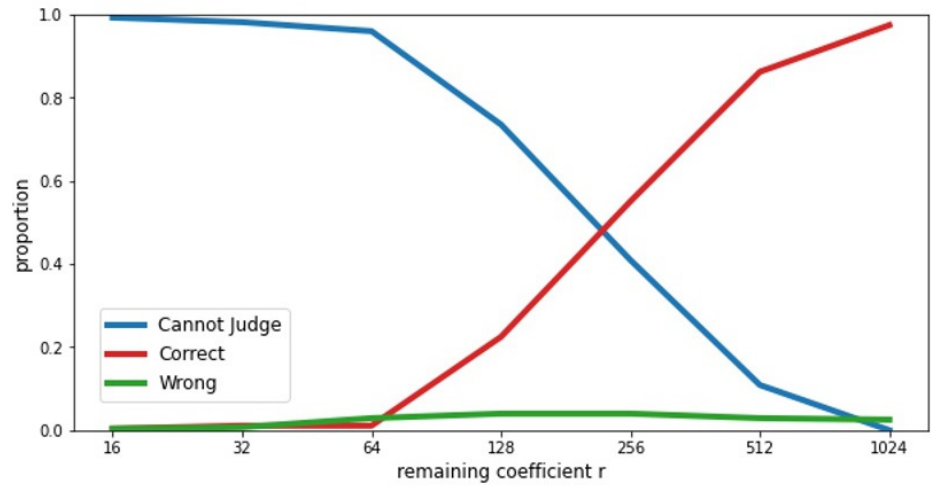
Figure 7. Survey Results. Most people could not judge until DCC ( r = 64 )